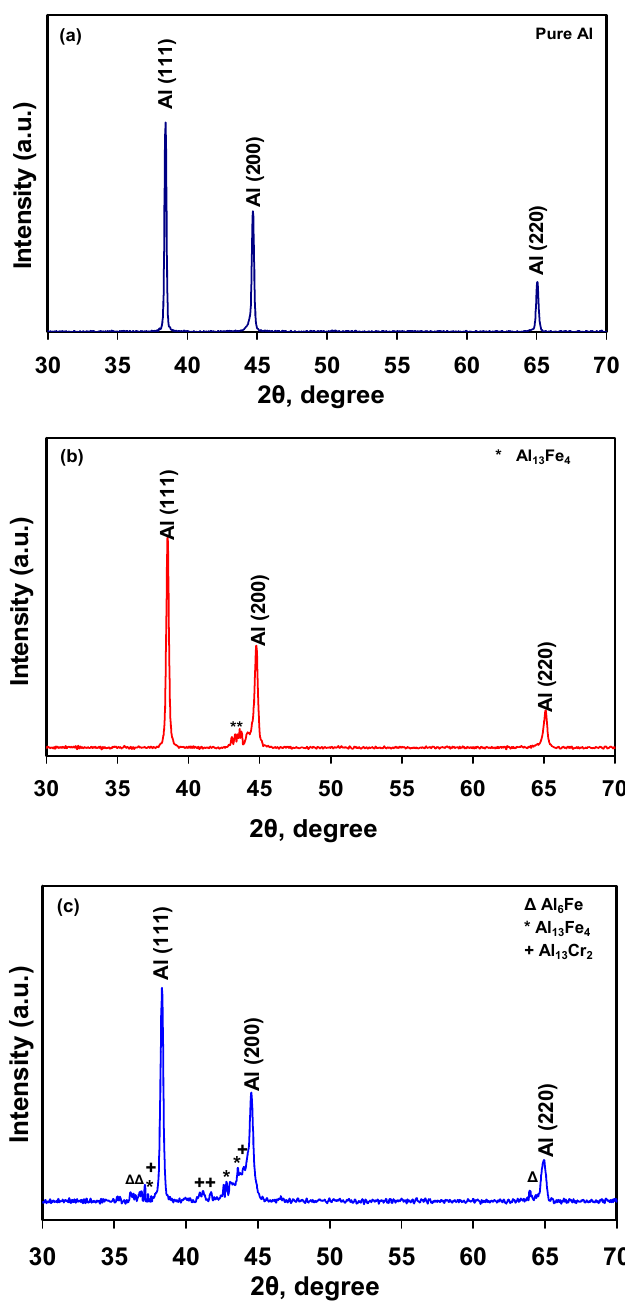
Figure 2. XRD analysis obtained for the nanocrystalline ( a ) Al, ( b ) Al-10% Fe and ( c ) Al-10% Fe-5%Cr alloy after sintering.